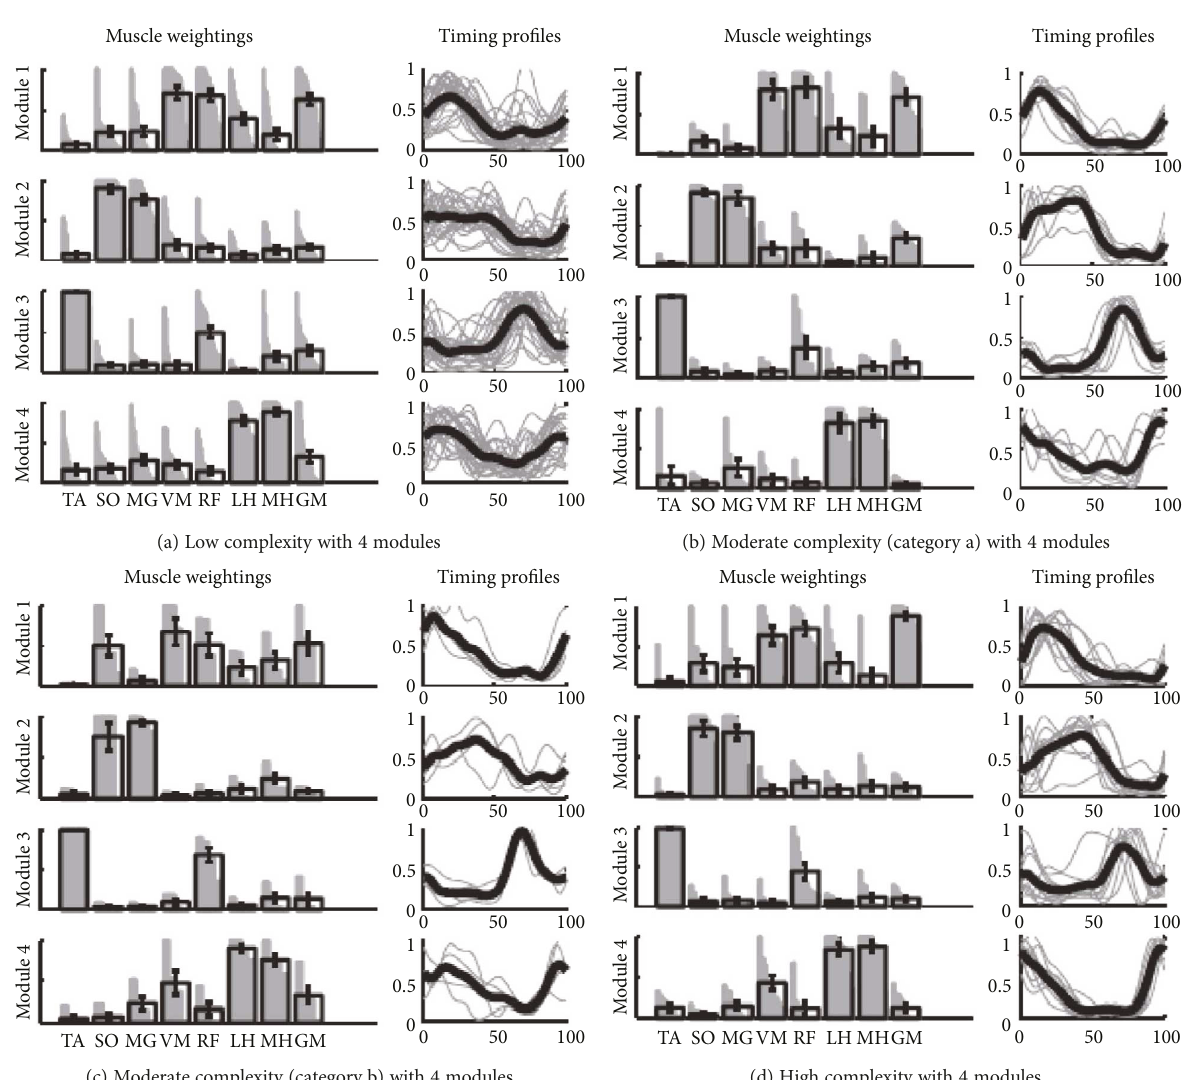
Figure 4: Image and caption reproduced from Clark et al. [14]. Module muscle weightings and activation timing pro fi les identi fi ed when NNMF was performed using 4 modules in all paretic legs. Refer to Figure 3 for the meaning of gray and black bars and lines. Associations within each group for muscle weightings and activation timing pro fi les are quanti fi ed in Table 3, (c) and (d), respectively. (a) The low complexity subgroup had modules with independent composition (muscle weightings) but similar timing of modules 1, 2, and 4. (b) The category A moderate complexity subgroup had modules with independent composition but similar timing of modules 1 and 2. (c) The category B moderate complexity subgroup had modules with independent composition but similar timing of modules 1 and 4. (d) The high complexity subgroup had modules with independent composition and activation timing pro fi les that were less correlated than in the moderate and low complexity subgroups